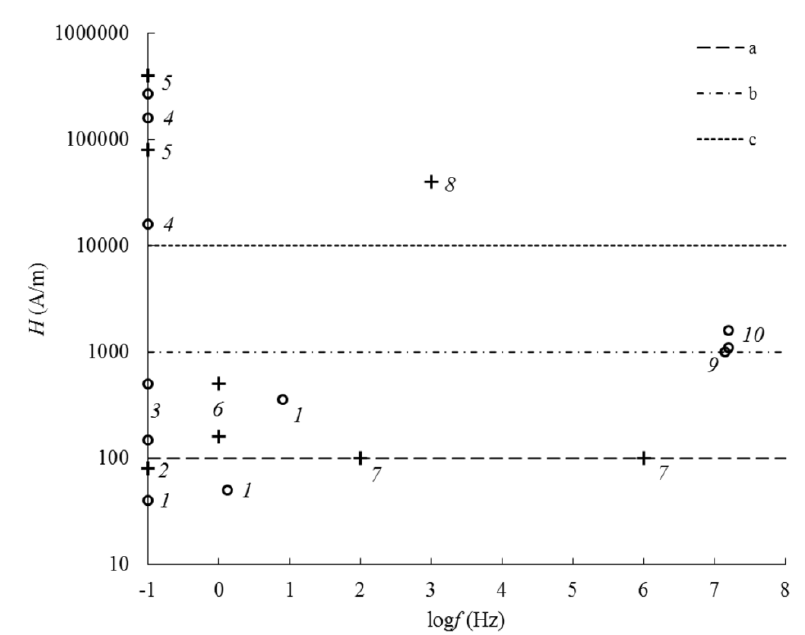
Figure 2. Frequency dependence of the magnetic field strength during the interaction of electromagnetic field with nanocomposites based on the Fe m O n –SiO 2 system in the frequency range 10 –1 –10 8 Hz: 1 —magnetization reversal (liquid), 2 —formation of anhysteretic remanent magnetization (ARM) (solid), 3 —reversible aggregation (liquid), 4 —irreversible formation of linear aggregates (liquid), 5 —Zeeman effect (solid, liquid), 6 —magnetization reversal (solid), 7 —dispersion of initial magnetic permeability (solid), 8 —destroying ARM (solid), 9 —nuclear magnetic resonance (liquid), 10 —nonlinearity magnetization in a longitudinal field (liquid). “+” Corresponds to a solid state, “ ○ ”—to a liquid state. a is the threshold level of change in the magnetic structure of the sample in the liquid state, b is the threshold level of change in the magnetic structure of the sample in the solid state, c is the threshold level of change in the microstructure of the sample in the liquid state.